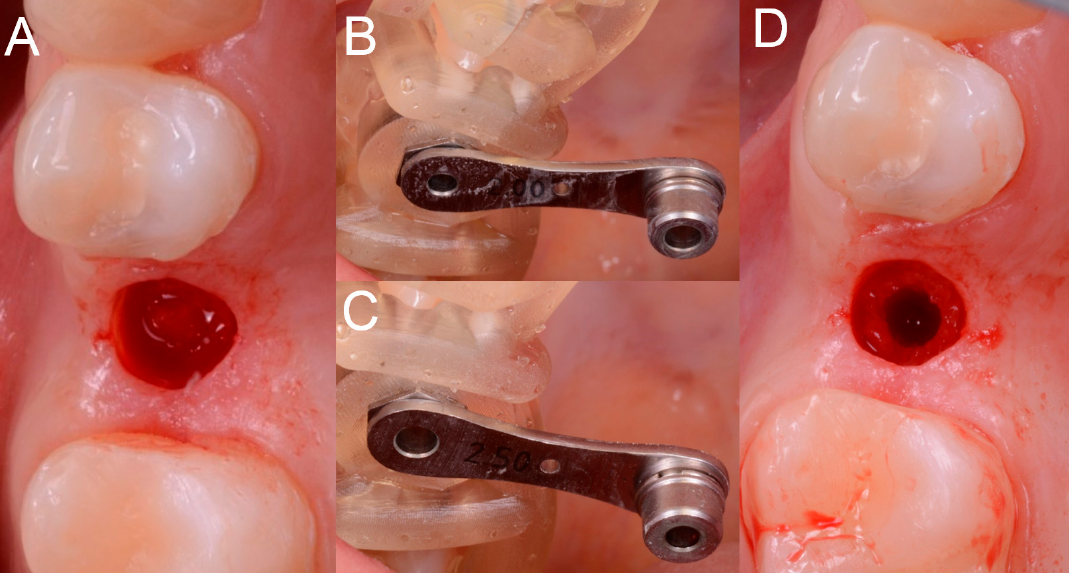
Figure 8. Different phases of surgery. ( A ) Mucotomy; ( B , C ) Preparation of the implant bed with different reducers inserted in the sleeve. ( D ) Occlusal view during preparation of the implant bed.